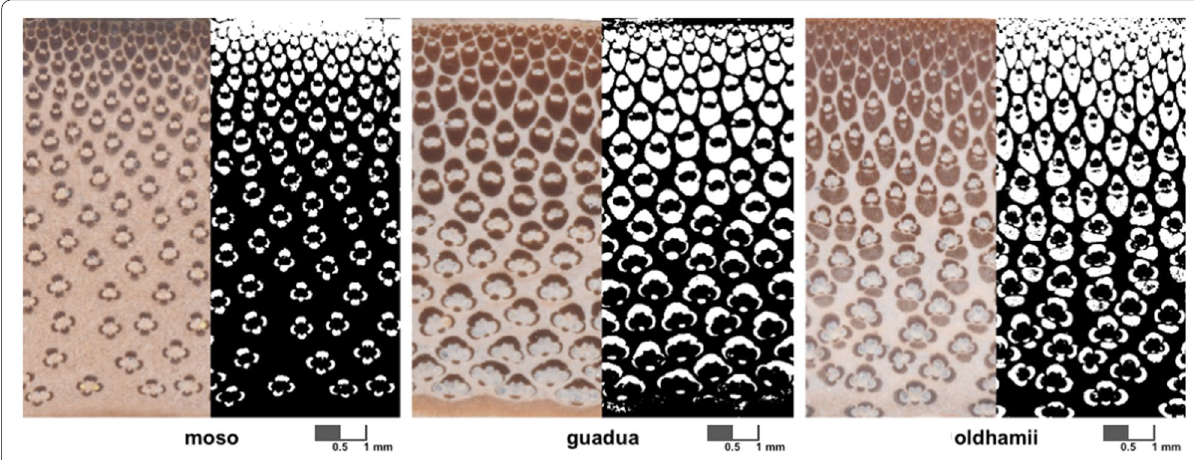
Fig. 8 Digital image of bamboo wall and corresponding binary